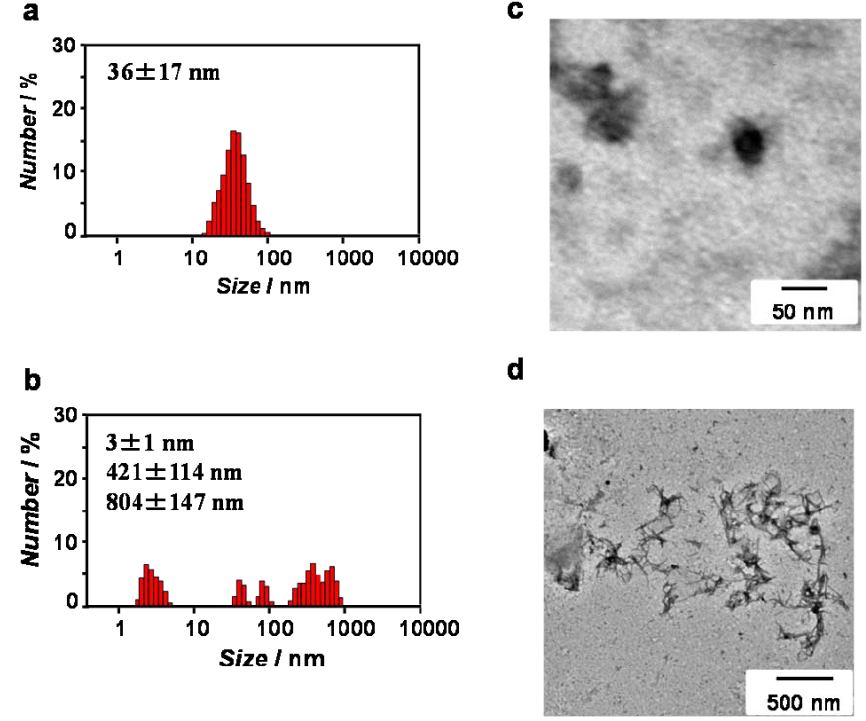
Figure 2. Size distribution obtained from DLS ( a , b ) and TEM images ( c , d ) for aqueous solutions of peptide 1 at 1.0 mM ( a , c ) and 0.1 mM ( b , d ) in 10 mM Tris-HCl buffer (pH 7.4) at 25 °C. The TEM samples were stained with sodium